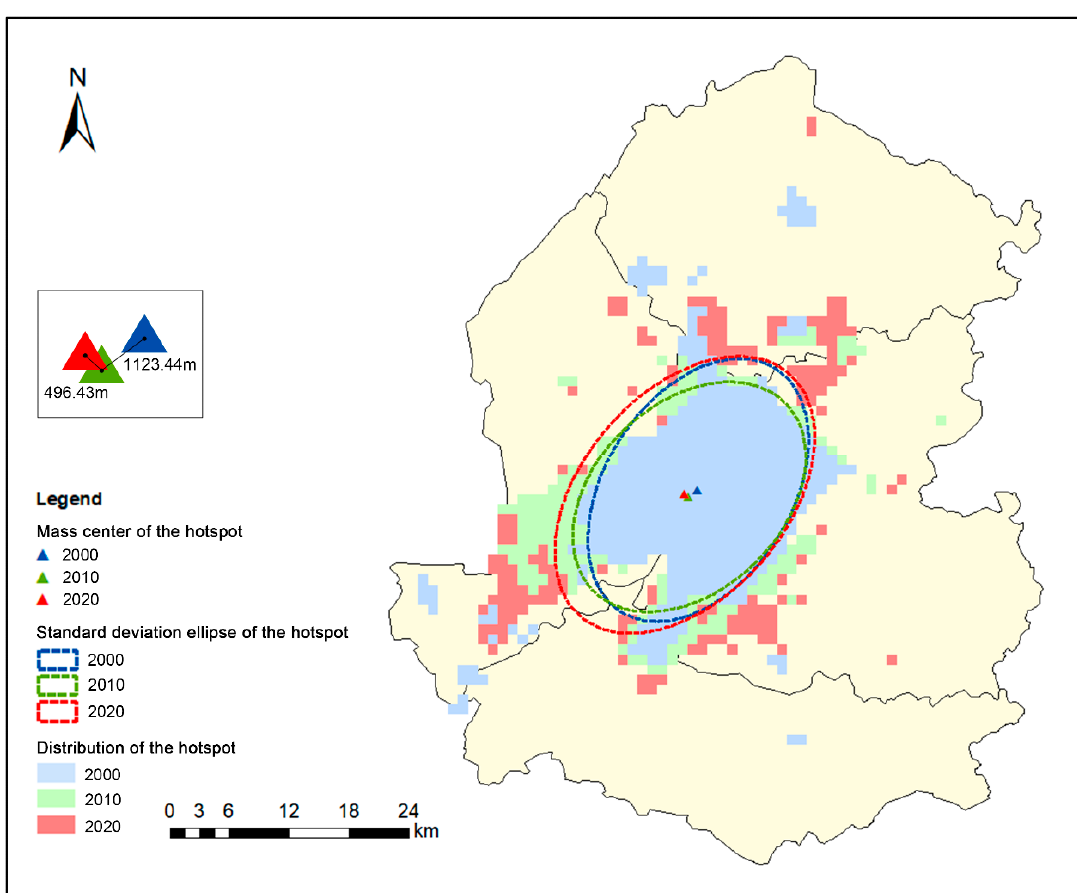
Figure 7. SDE of the hotspot. Table 5. Mean and SD of LST for each land type from 2000 to 2020.